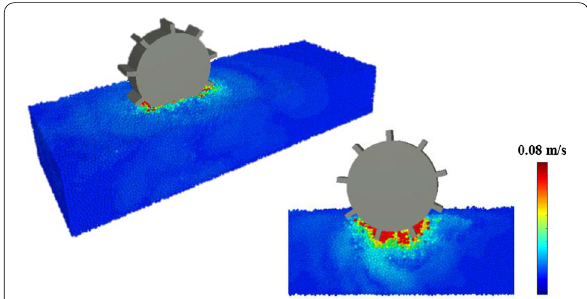
Fig. 8 Example of a SSDEM simulation of a simplified MMX rover wheel traversing a bed of 180,000 cohesionless spherical grains. The wheel is 214 mm in diameter and the grains are 6 diameter. The simulation was conducted under Earth-gravity using Chrono (Sunday et al. 2020). The grains are coloured by velocity